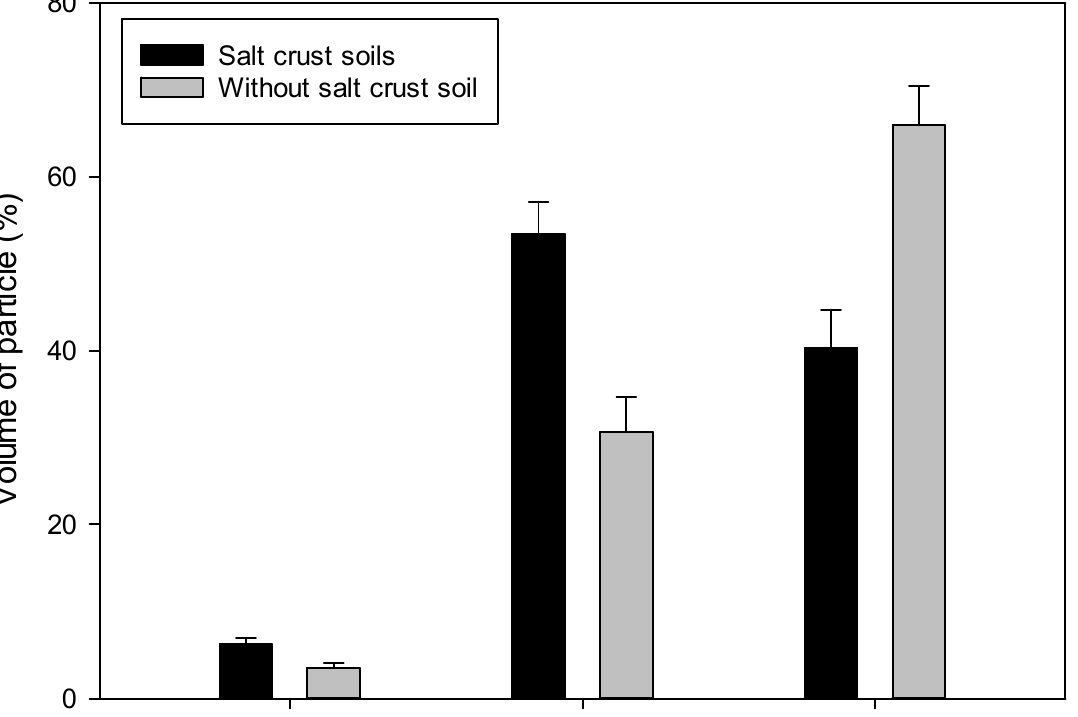
Figure 3. Comparison of the clay, silt, and sand contents of soils with and without a salt crust. D50 and D95 are the mean diameters of particles representing the 50th and 95th percentiles of the particle size distribution, respectively, as measured by volume. D50 exhibited means of 40.32 µ m (4.62 µ m SE) for salt crusts and 79.83 (9.16 µ m SE) for non- crusted soils, and D95 had means of 142.77 µ m (9.49 µ m SE) for salt crusts and 221.42 µ m (22.35 µ m SE) for non-crusted soils, indicating that salt-crusted soils contained finer particles than non-crusted soils and that there was a significant difference between the two sample types for D50 and D95 (Table